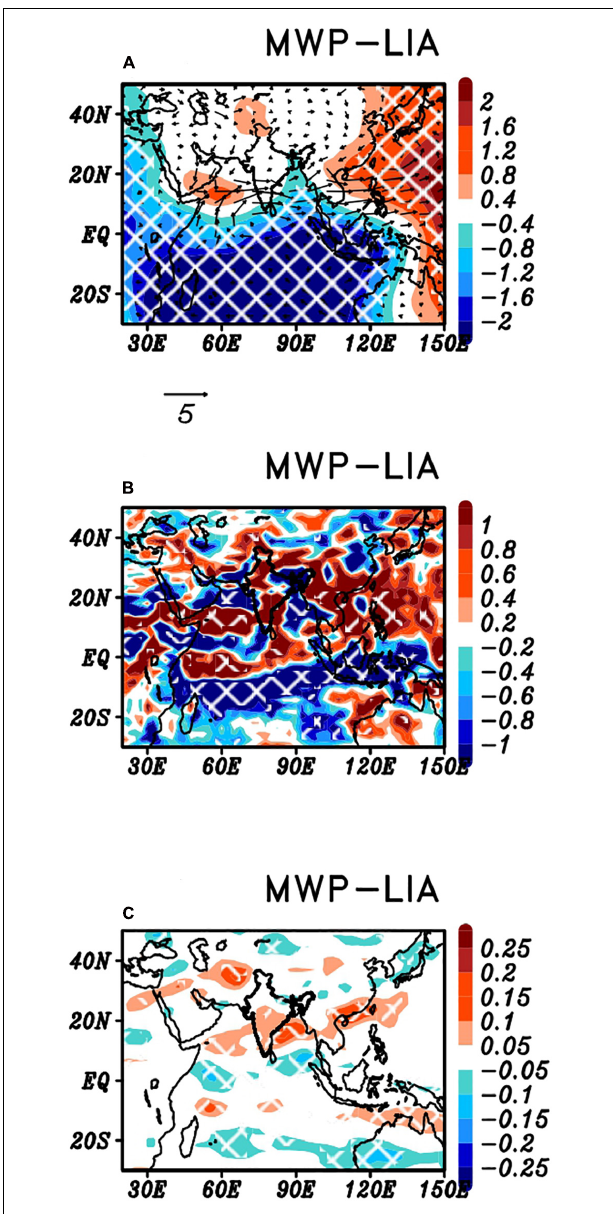
FIGURE 6 | (A) Spatial distribution of the simulated 850 hPa differences in the time-averaged JJAS velocity potential “ χ 850” (m 2 s − 1 ; Shaded), and overlaid by the mean monsoon winds (m/s; Vectors) for MWP period relative to that for the LIA. (B) Show spatial distributions of simulated 600 hPa differences in the time-averaged JJAS Moisture Flux Convergence [10 − 5 g/(kg − s )]. (C) Shows spatial distributions of simulated 500 hPa relative vorticity ( × 10 − 5 S − 1 ) for the MWP period relative to that for the LIA. Hatched region represents a statistically significant region at a 95% confidence level from the two-tailed Student’s t